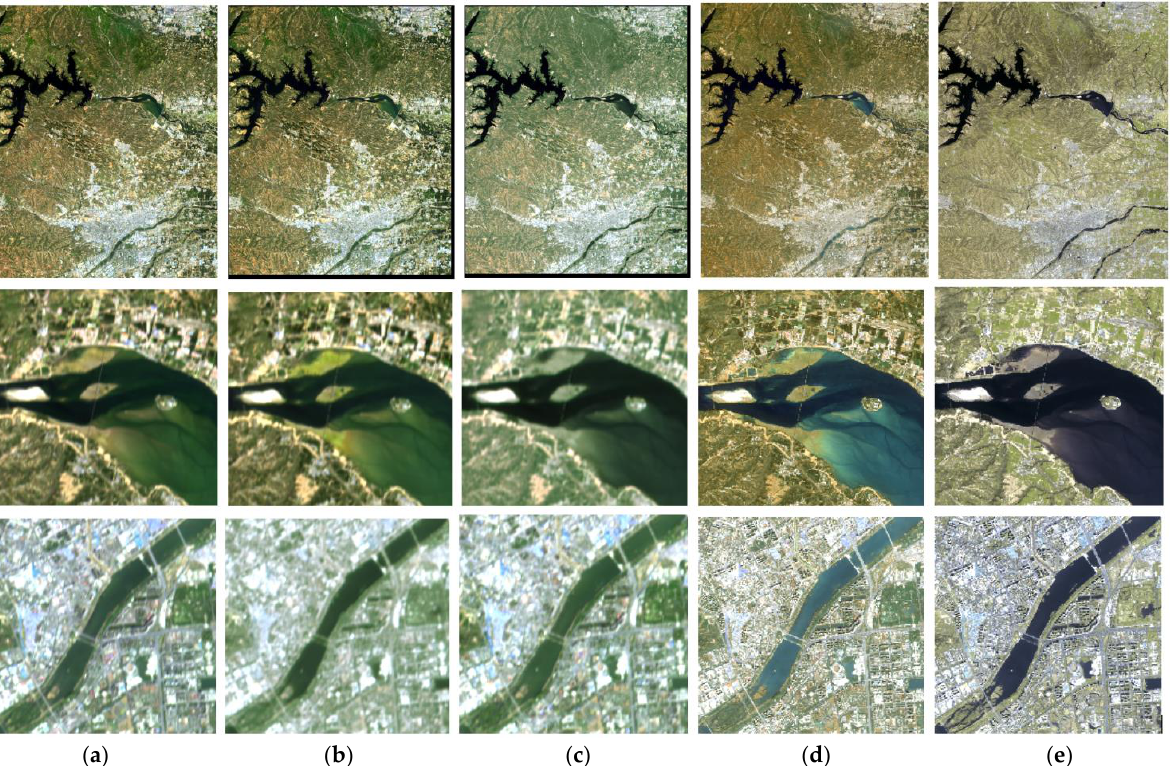
Figure 16. RGB Composites of fusion results comparison dataset II. ( a ) Original Image, ( b ) SRE- ResNet, ( c ) HSCNN, ( d ) CNMF, ( e ) J-SLoL.